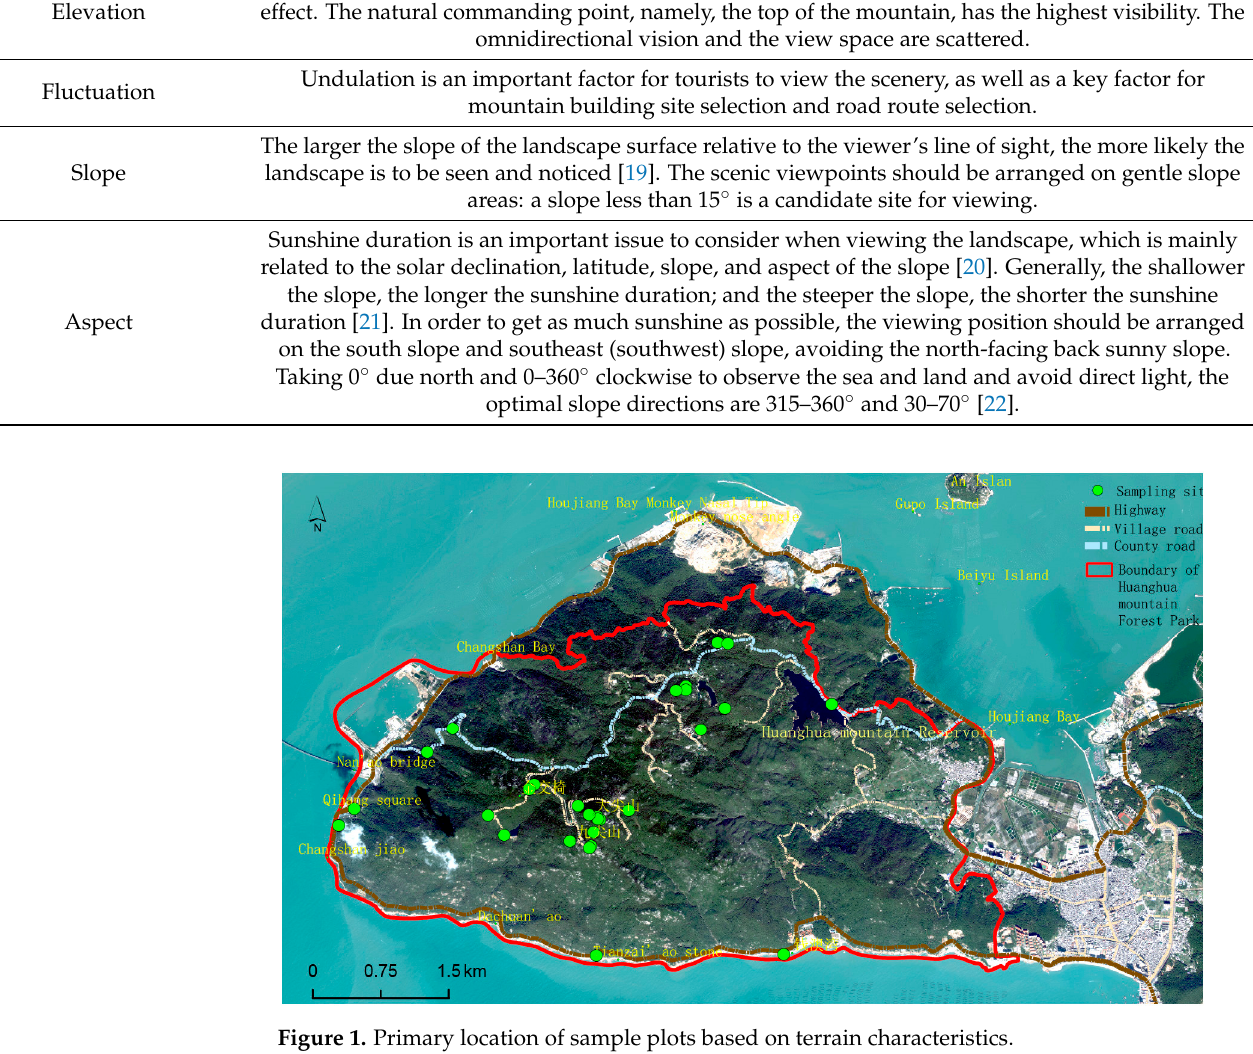
Figure 1. Primary location of sample plots based on terrain